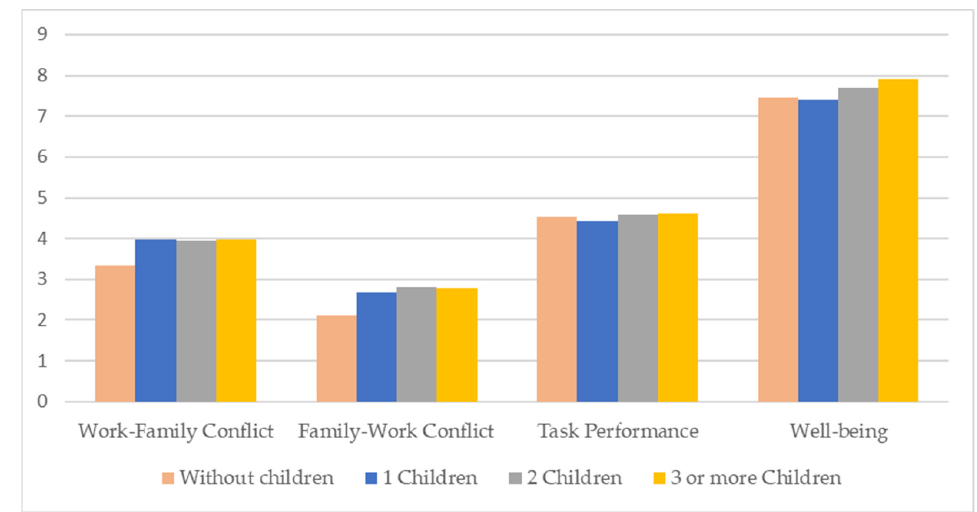
Figure 3. Distribution of variables according to the number of children.